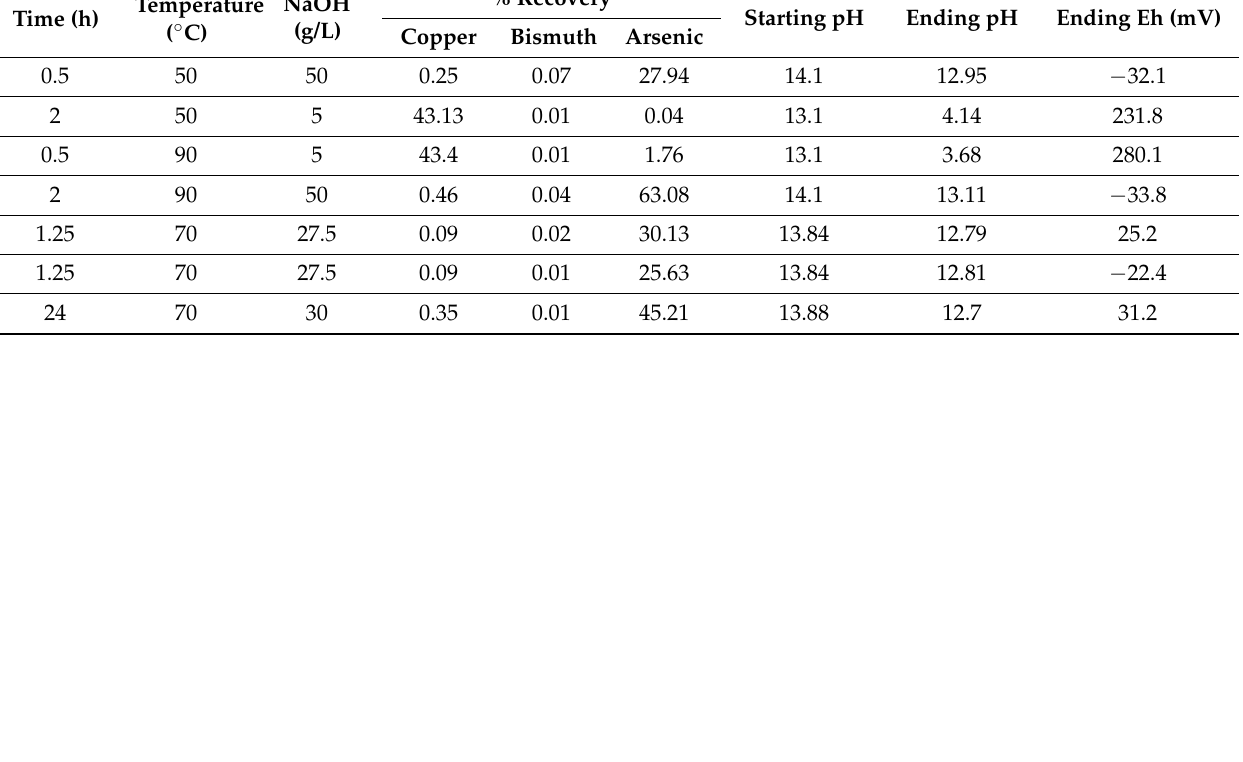
Table 11. Elemental recoveries (%) to leachates of caustic trials, pH data, and Eh data. Trial Time